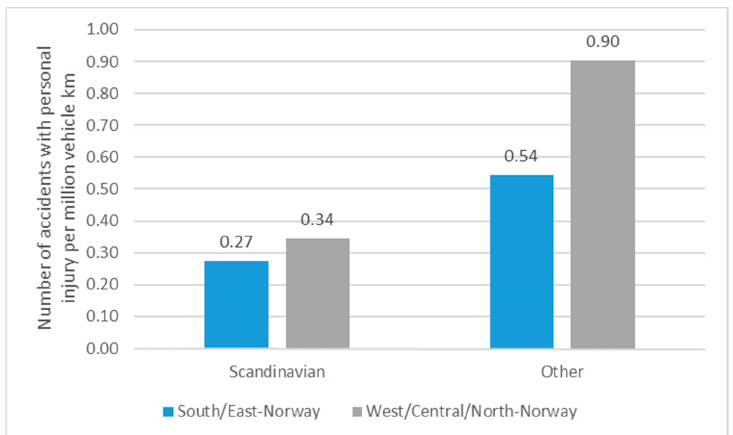
Figure 3. Number of heavy goods vehicles in police reported traffic accidents with personal injuries per million kilometres in Norway from 2007 to 2014, comparing the western/central/northern regions of Norway with the eastern/southern regions, for HGVs registered in Scandinavia and HGVs registered in non-Scandinavian EU countries. Table 6. Proportions of heavy goods vehicles involved in police reported road accidents with personal injuries in Norway from 2007 to 2014, for Scandinavia and non-Scandinavian EU countries, in the winter (October–March) and the summer (April–September).